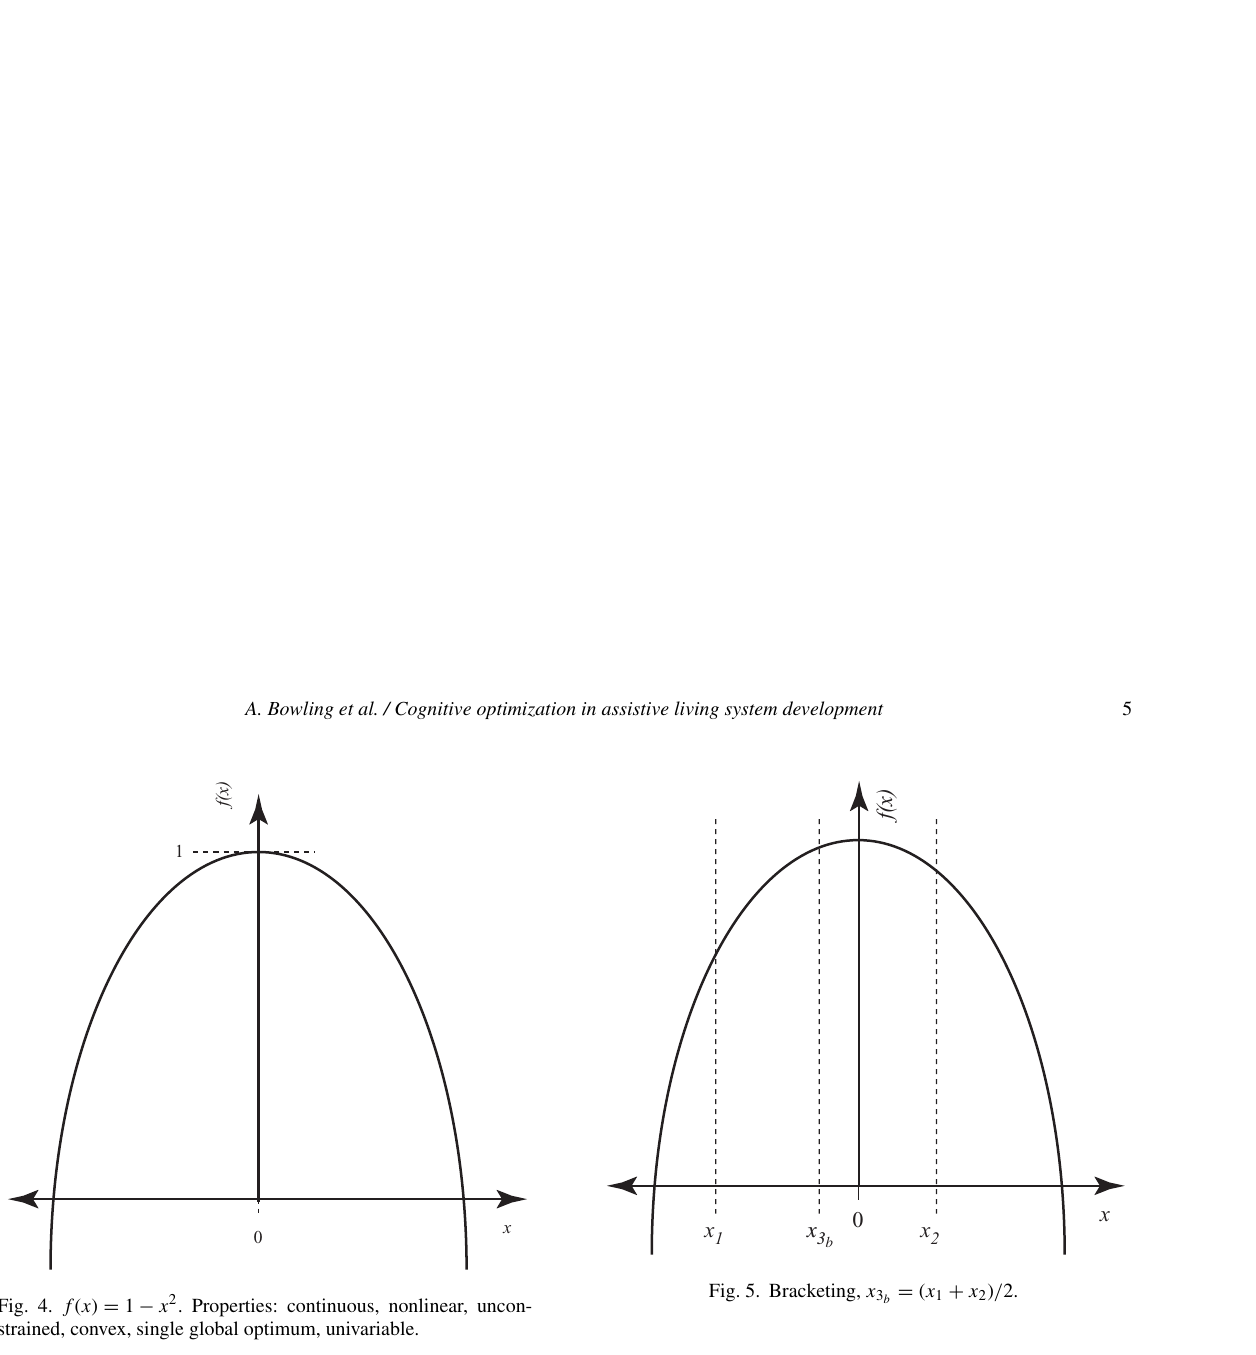
Fig. 4. f ( x ) = 1 − x 2 . Properties: continuous, nonlinear, uncon- strained, convex, single global optimum, univariable.